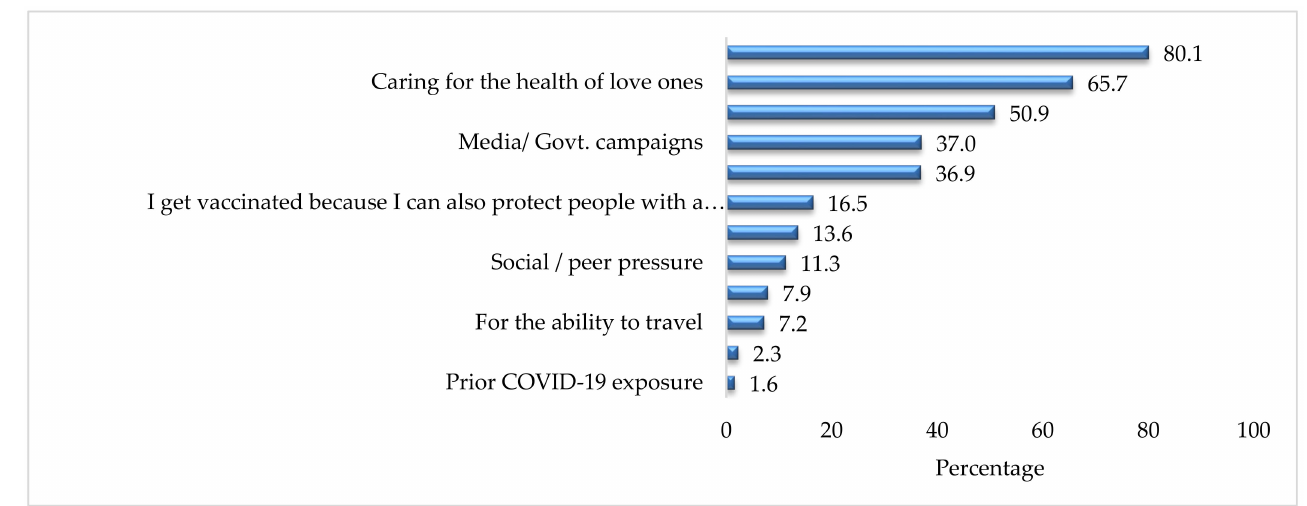
Figure 3. Reasons to get vaccination (%) ( n = 794).